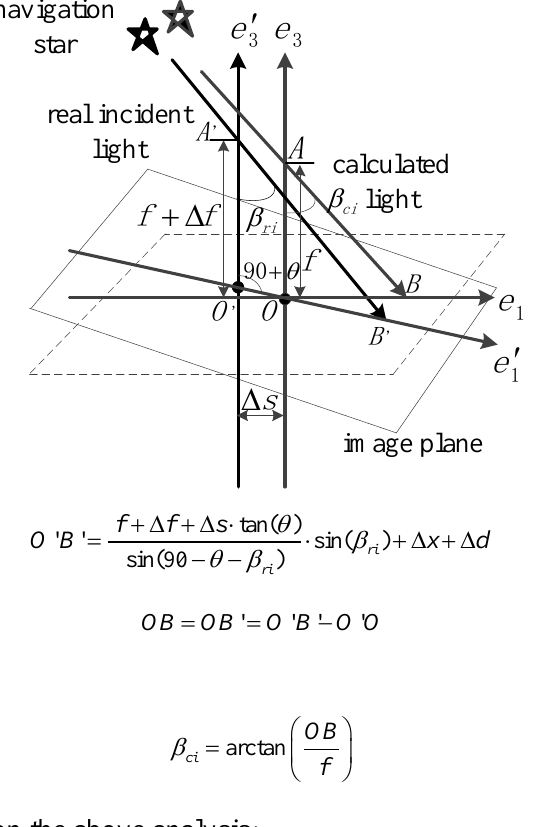
Figure 2. Sketch of complete error